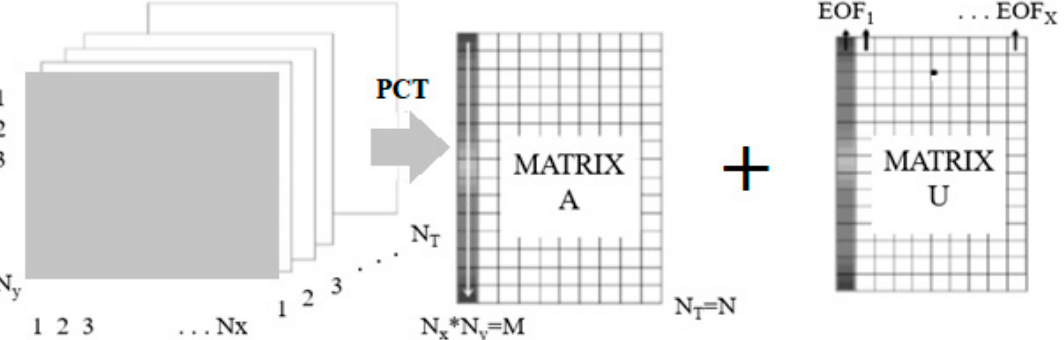
Figure 4 . Thermographic data conversion from a 3D sequence to a 2D A matrix in order to apply Singular Value Decomposition (SVD) and finally conversion of 2D U matrix into a 3D matrix containing the Empirical Orthogonal Functions